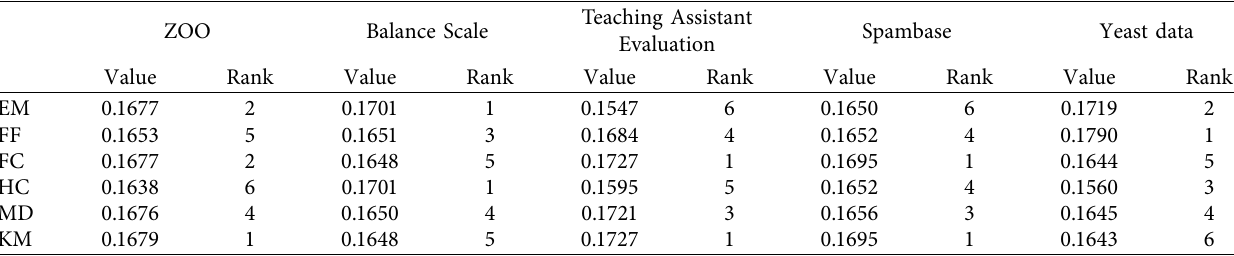
Table 5: Rankings of WSM for the five assigned UCI data sets.